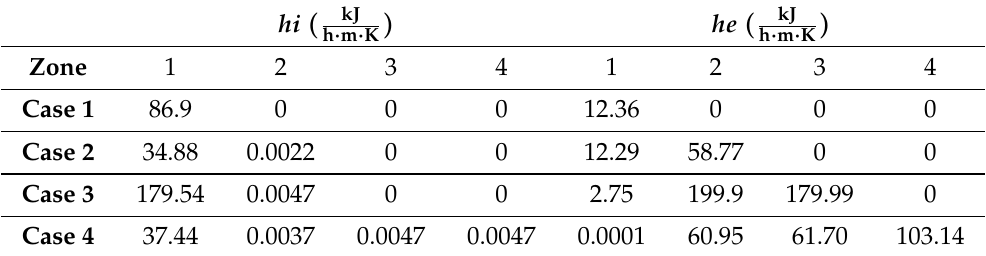
Table 2. Heat transmission coefficients for the charging process.